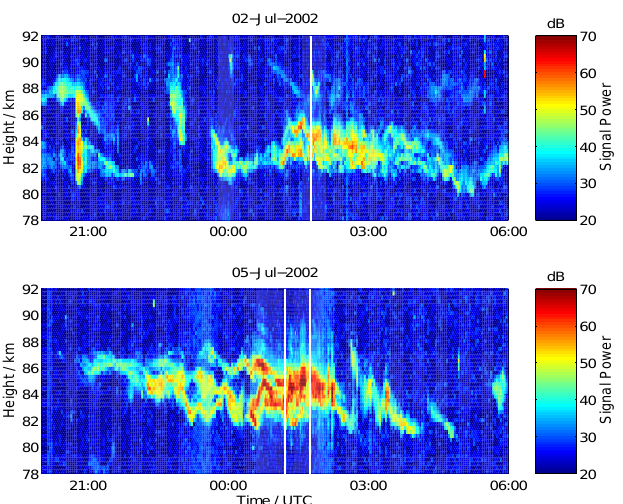
Fig. 1. Overview of the signal power received from the vertical beams on 2 July and 5 July 2002 as height-time-intensity plots. Shown are the periods of 10h around the sounding rocket launches which are indicated by the vertical white lines.